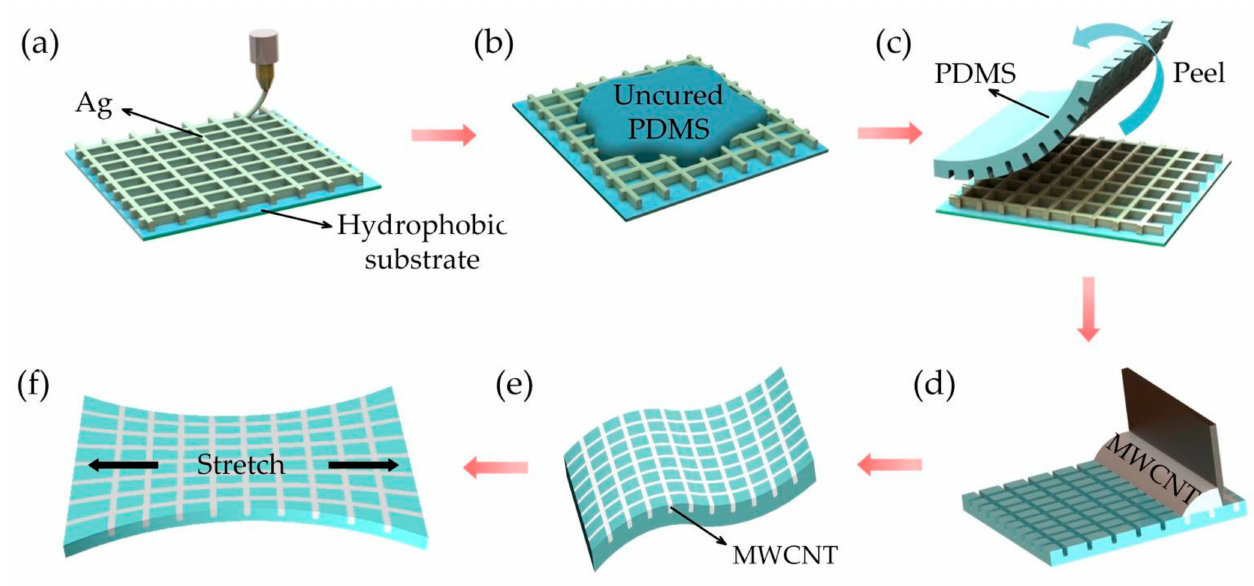
Figure 1. Fabrication process of the flexible strain sensor with the embedded MWCNT